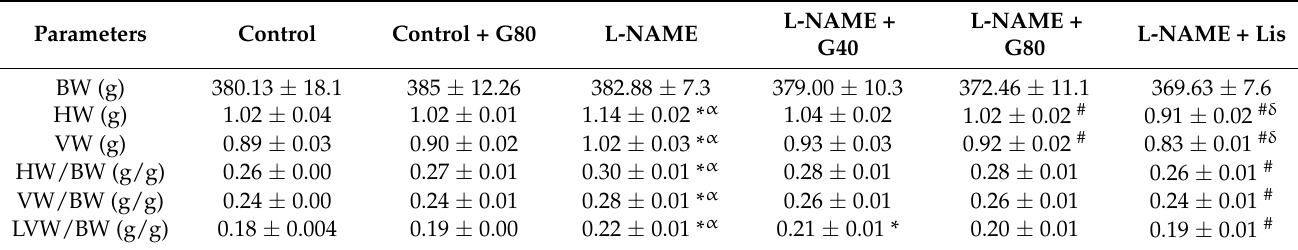
Table 1. Effect of genistein on body weight (BW) and heart weight (HW) in L-NAME-induced hypertensive rats.